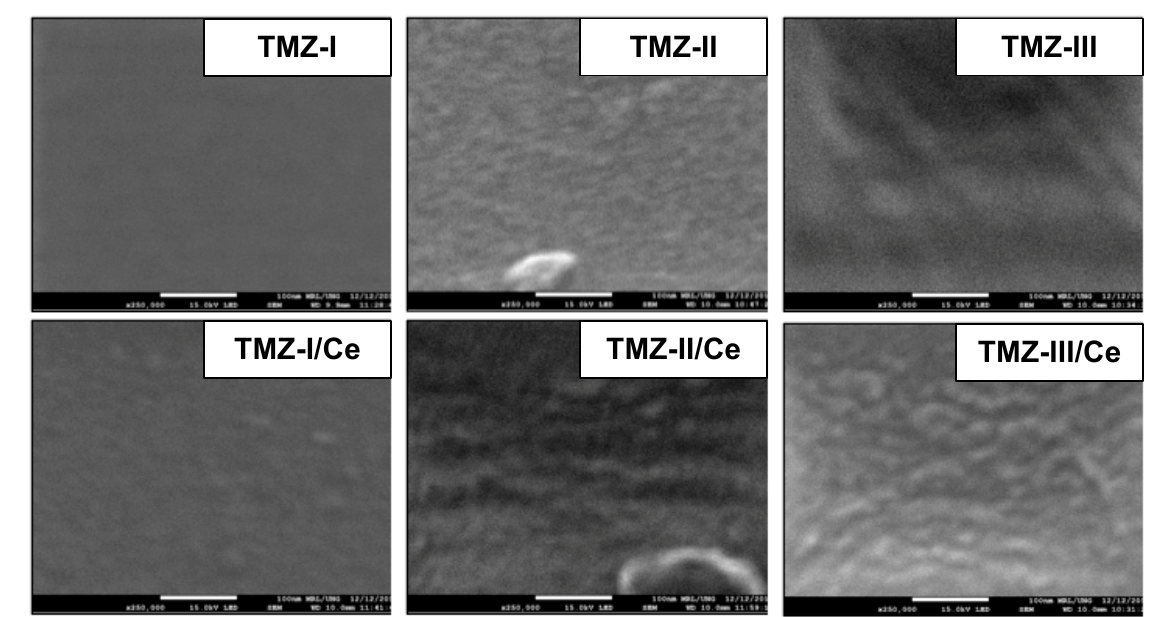
Figure 9. The SEM images (250,000×) of the TMZ coatings.